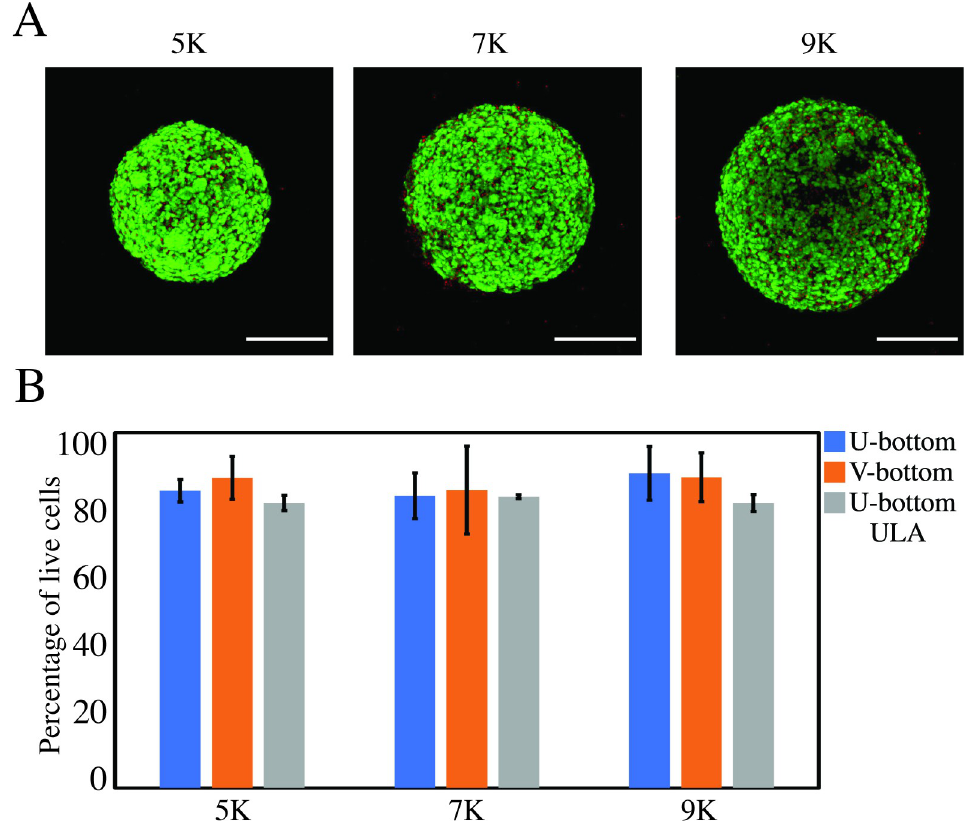
Fig 4. Cell viability in EBs fabricated using different methods. (A) Live/Dead assay conducted on EBs fabricated in U-bottom plates treated with anti-adherence solution, in V-bottom plates treated with anti-adherence solution, and in ULA plates. Calcein AM and ethidium homodimer-1 were used to stain live (green) and dead (red) cells, respectively. EBs were stained at day 6, before embedding in Matrigel for differentiation. Scale bar: 200 μ m. (B) EBs fabricated in ULA plates (control) and conventional U-bottom or V-bottom wells treated with anti-adherence solution exhibited statistically similar cell viabilities ( > 80%).